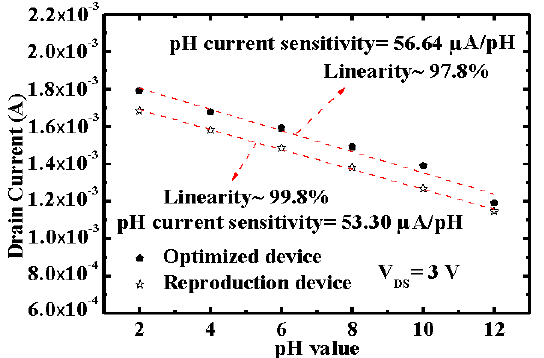
Figure 6. The drain current ( 𝐼 (cid:3005)(cid:3020) ) as a function of pH value. Figure 7 reveals the transfer characteristic curves ( 𝐼 (cid:3005)(cid:3020) – 𝑉 (cid:3019)(cid:3006)(cid:3007) ) characteristics of the In 0.9 Ga 0.1 O EGFET pH sensors with the pH value from 2 to 12 at a fixed drain–source volt- age of 0.3 V. The 𝐼 (cid:3005)(cid:3020) – 𝑉 (cid:3019)(cid:3006)(cid:3007) characteristics of the In 0.9 Ga 0.1 O EGFET pH sensors in the linear region can be expressed as following Equation [26]: